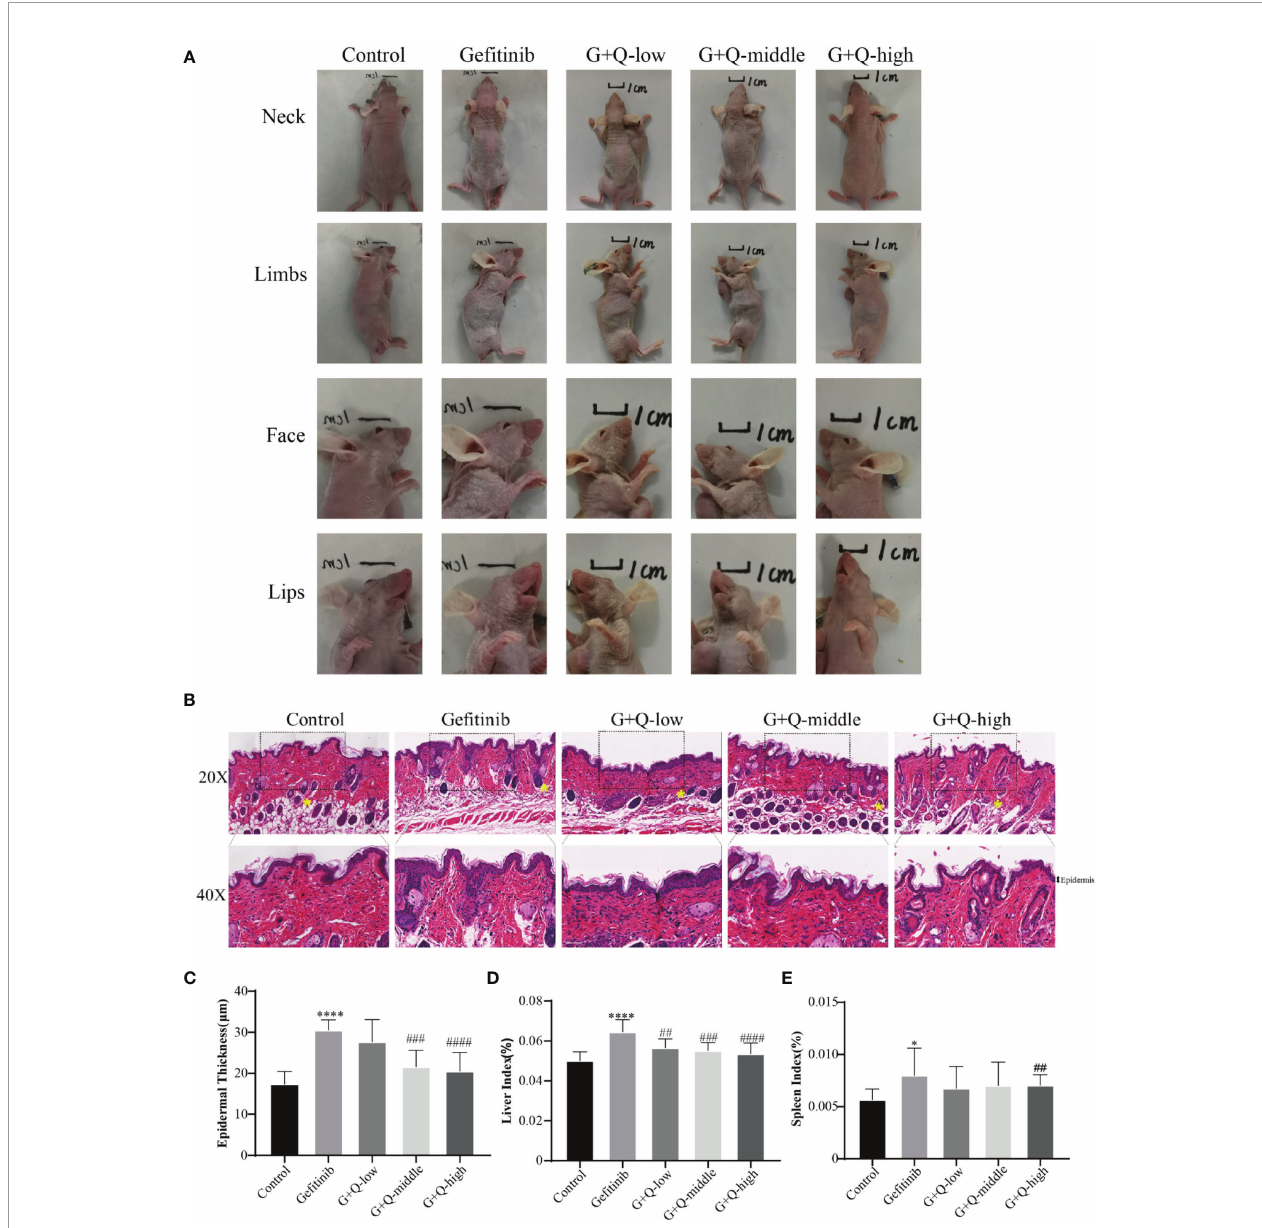
FIGURE 2 | In vivo experiments showed that QYSLS effectively improved the adverse skin reactions caused by ge fi tinib. (A) Skin condition of the neck, limbs, face, and lip of mice in each group. (B) H&E staining of skin tissue from mice in each group. (C) Quantitative analysis of skin epidermal thickness. (D) Liver index of mice in each group. (E) Spleen index of mice in each group. “ * ” compared with Control, *p < 0.05, ****p < 0.0001. “ # ” compared with Ge fi tinib, ## p < 0.01, ### p < 0.005, #### p <